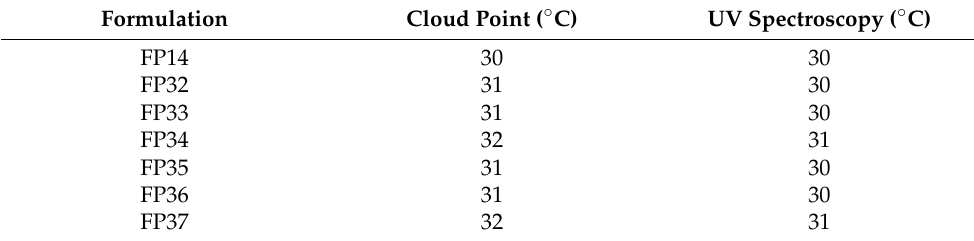
Table 2. Comparison table illustrating the LCST values obtained from cloud-point analysis and UV